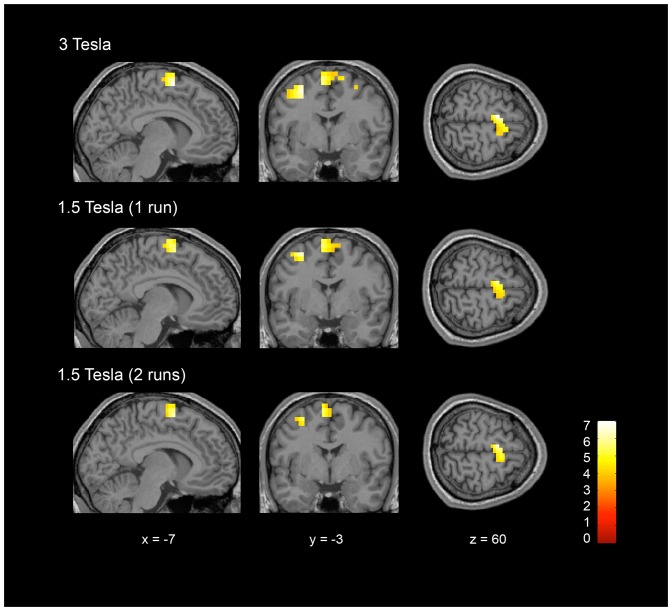
ROI group results showing activation of SMA and dorsal premotor cortex for the motor imagery task (i.e. imagine playing tennis) compared to rest at 3T and 1.5T (including 1 and 2 runs).For display, results are thresholded at an uncorrected p<0.001 and rendered on a canonical single subject T1 MRI image.